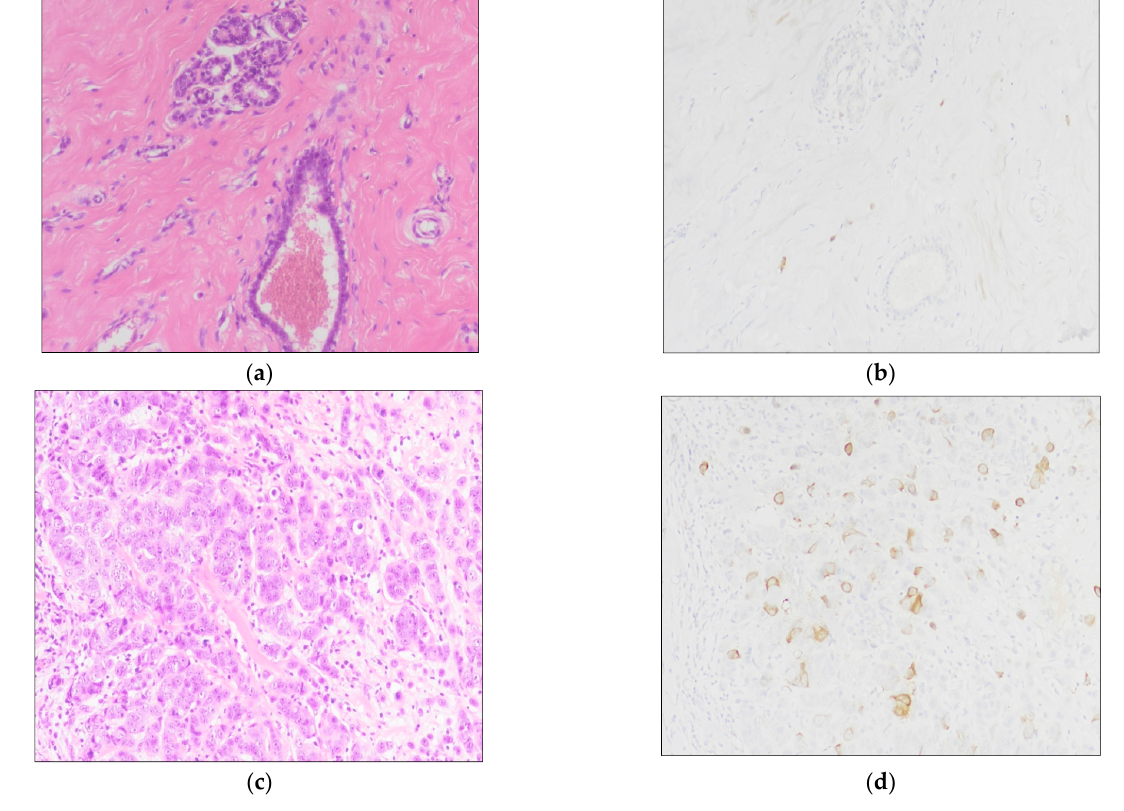
Figure 1. TK1 expression in normal and neoplastic tissue samples: ( a , b ) normal breast tissue sample with no expression of TK1; ( b , c ) BC tissue sample with moderate to strong cytoplasmic TK1 expression. ( a , c ) Hematoxylin and eosin staining. ( b , d ) IHC staining for TK1 (see text). Magnification for all images is 200×.